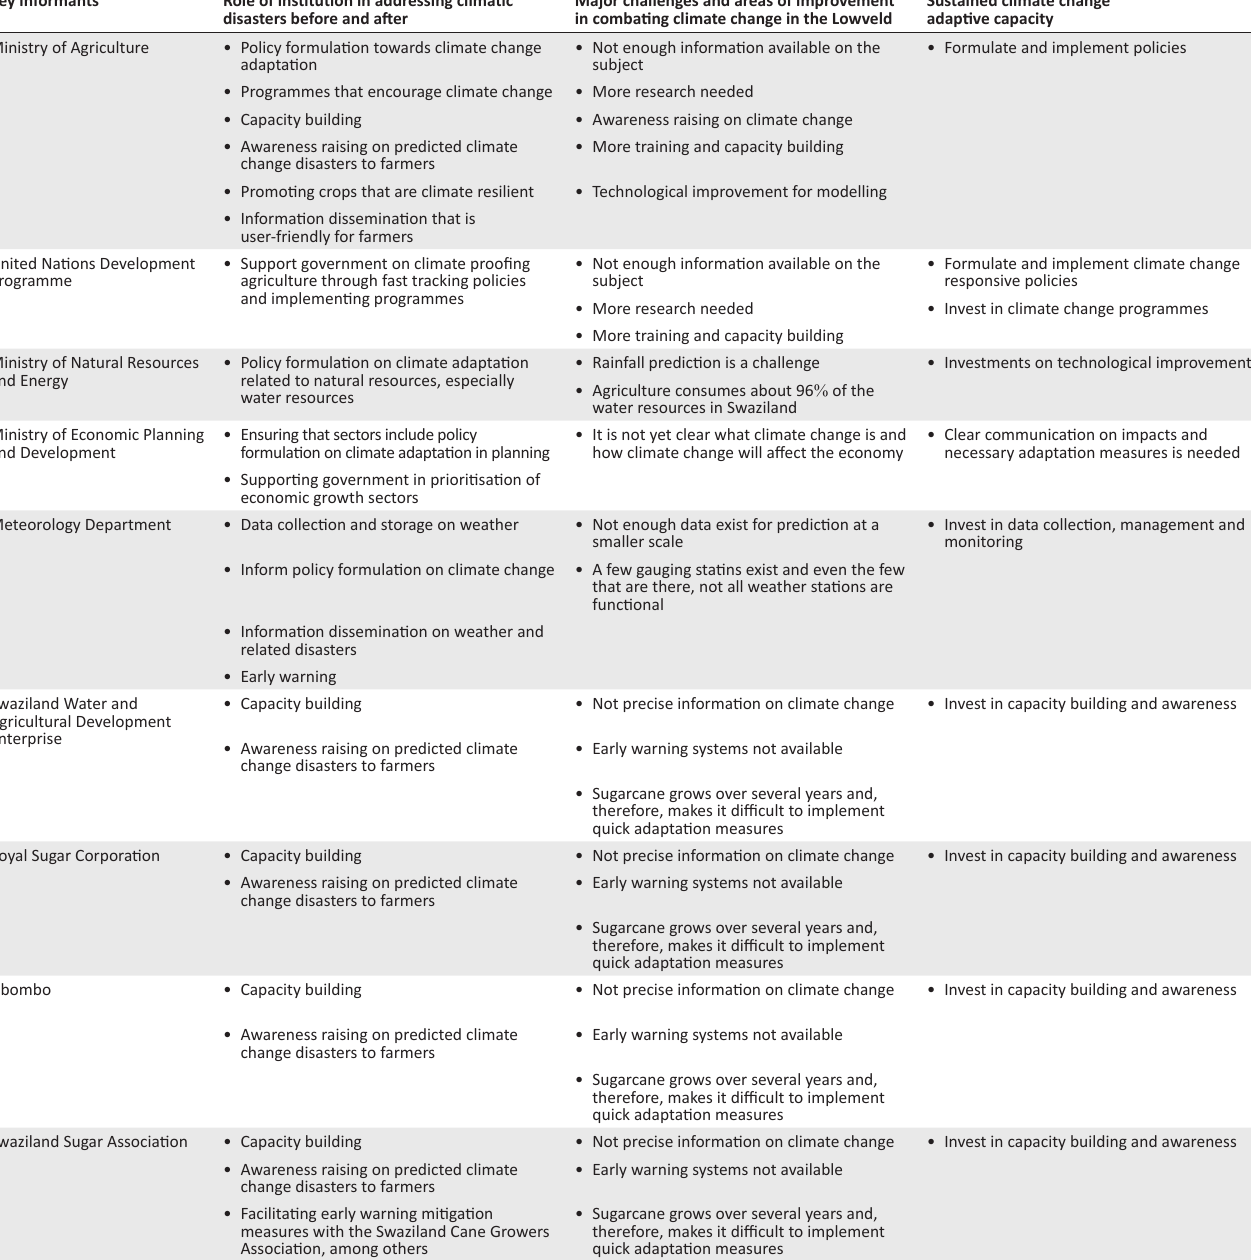
TABLE 2: Adaptive measures for climate change. Key